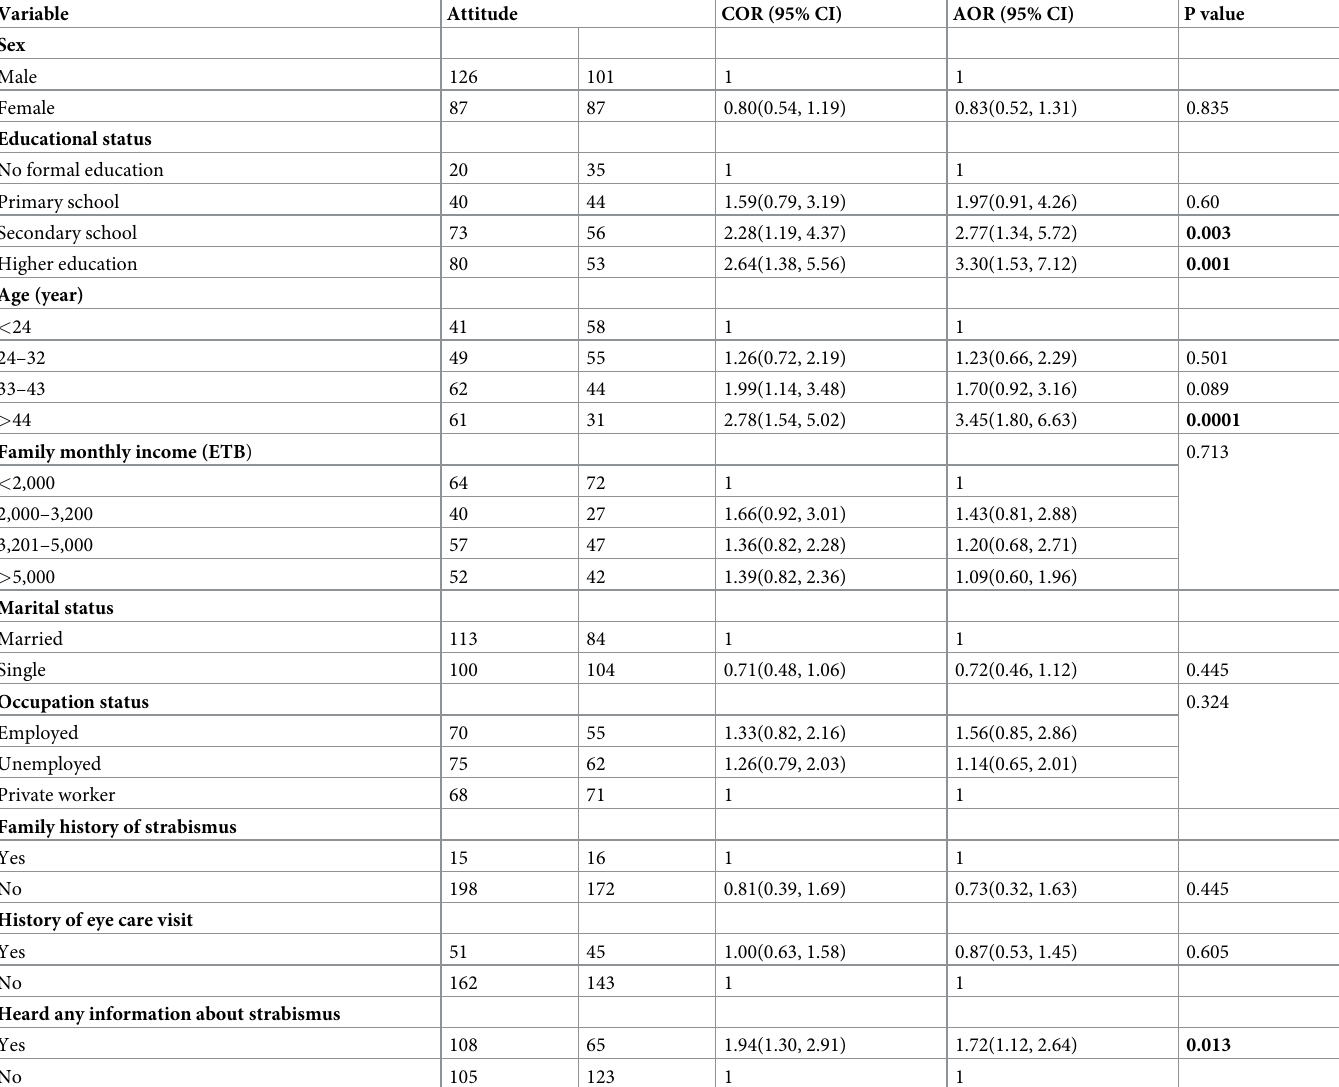
Table 6. Factors associated with attitude towards strabismus among adult participants living in Woreta town, Northwest Ethiopia, 2020 (n =